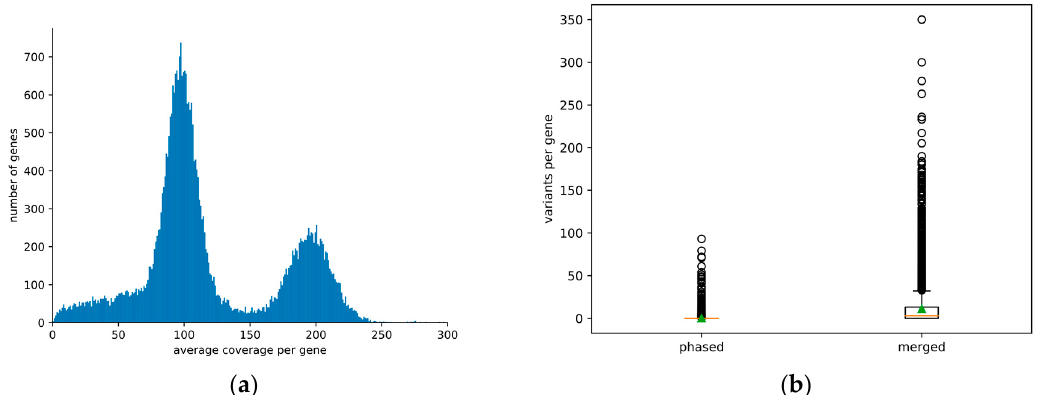
Figure 1. ( a ) Distribution of the average sequencing read depth per gene model. Predicted gene models were classified into phase-separated and merged based on the average read depth value deduced from the analysis presented here. The haploid read depth with Illumina short reads ranges from 50-fold to 150-fold. ( b ) Number of heterozygous sequence variants in phase separated and merged genes. The high proportion of heterozygous variants in merged gene models is due to the mapping of reads originating from two different alleles to the same region of the assembly.